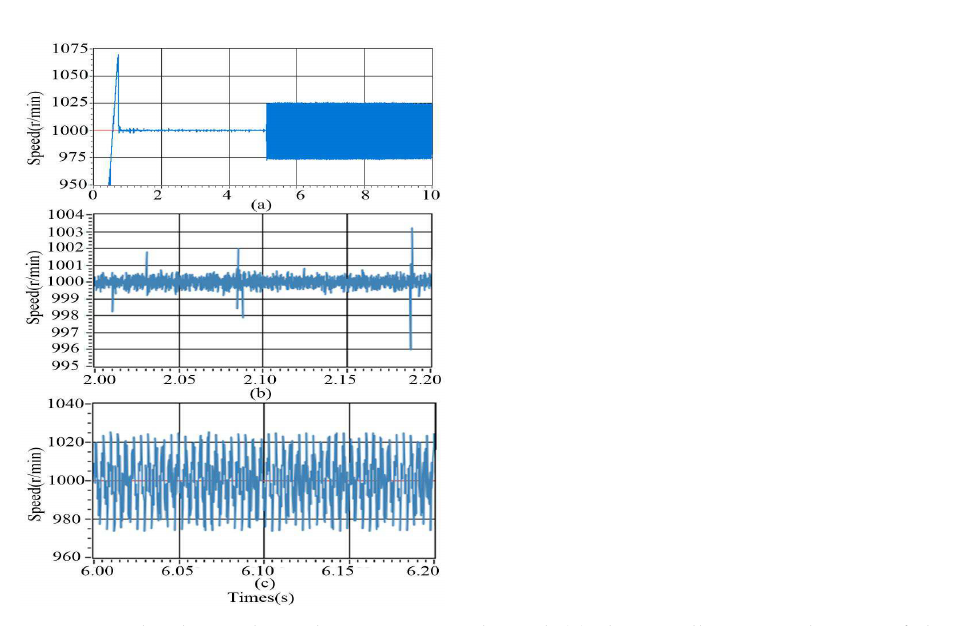
Figure 32. The observed speed using PI at rated speed. ( a ) The overall response diagram of observed